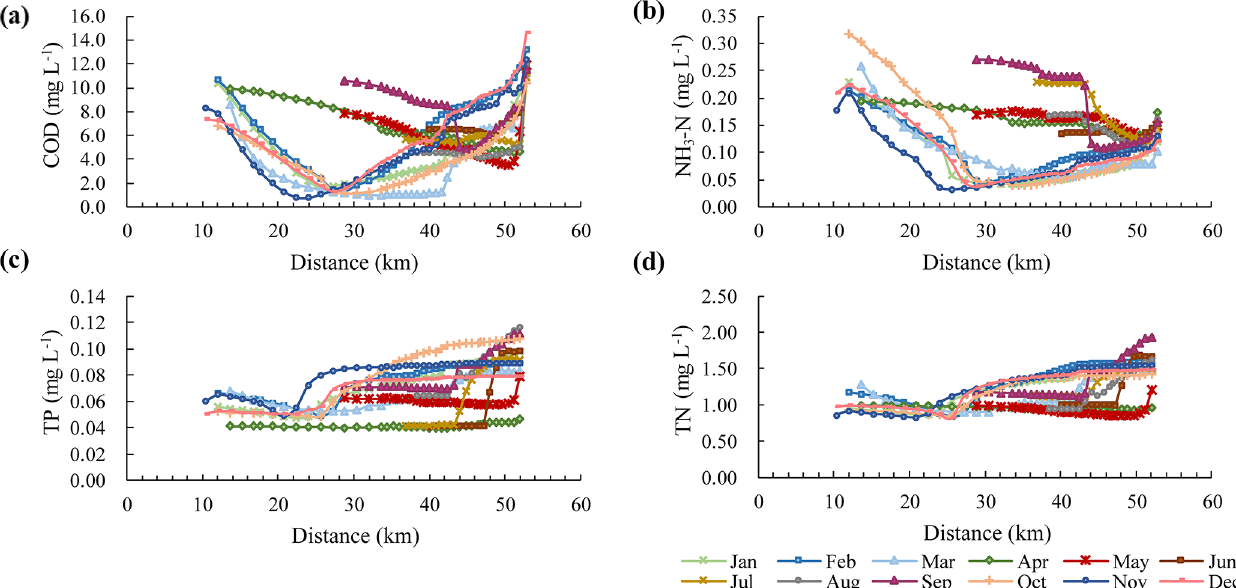
Figure 15. Variation in surface water quality in different months along the tributary bay. (a) Variation in chemical oxygen demand; (b) vari- ation in ammonia nitrogen, (c) variation in total phosphorus; and (d) variation in total